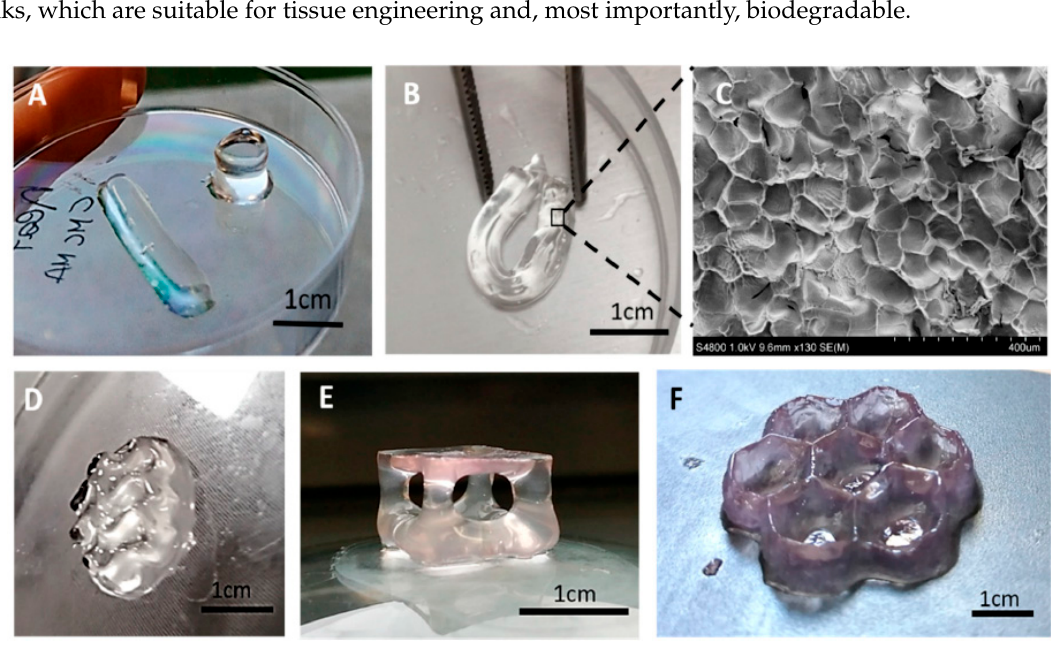
Figure 6. Synthetic route of nanocrystalline cellulose-silver (CNC-Ag) composite [110].